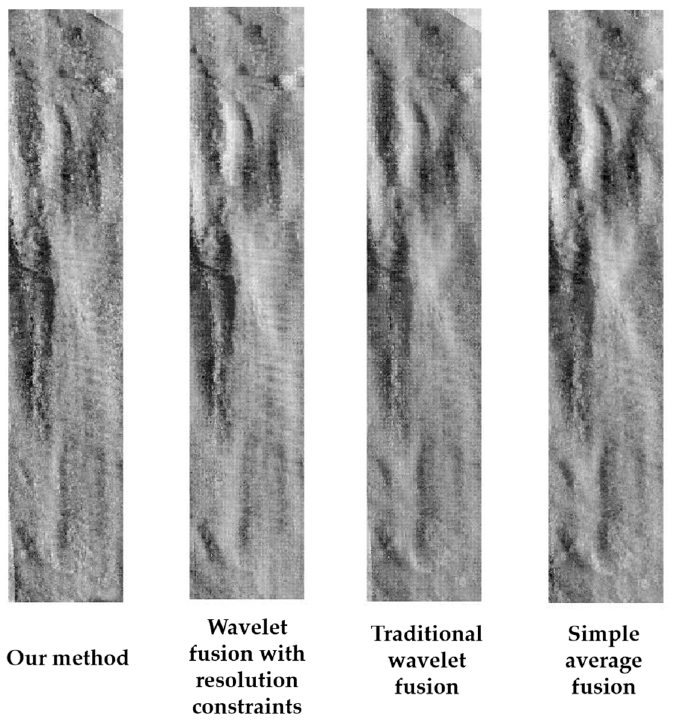
Figure 8. Fusion results of the four different methods.